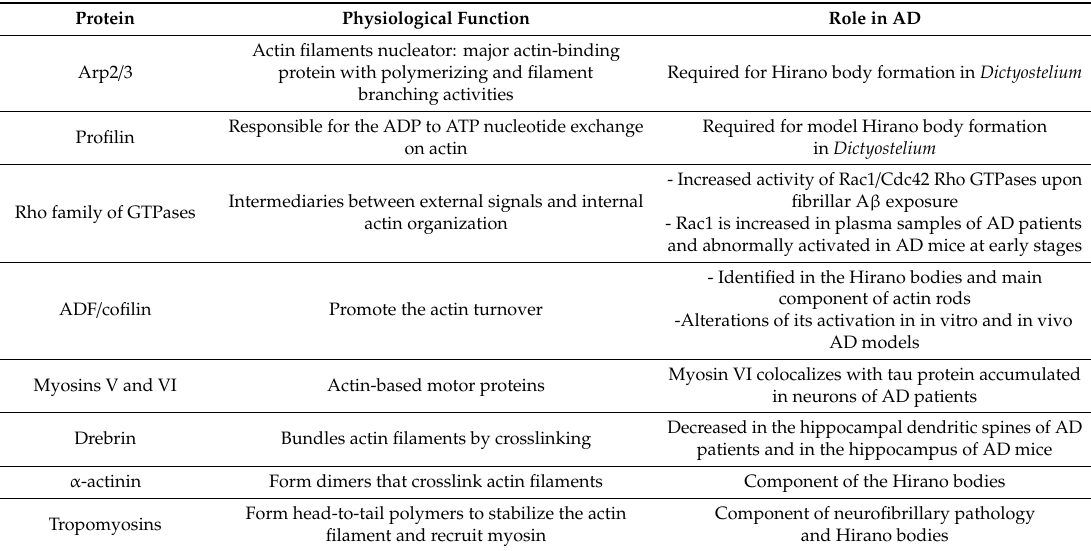
Table 1. Actin-binding proteins: physiological role and involvement in